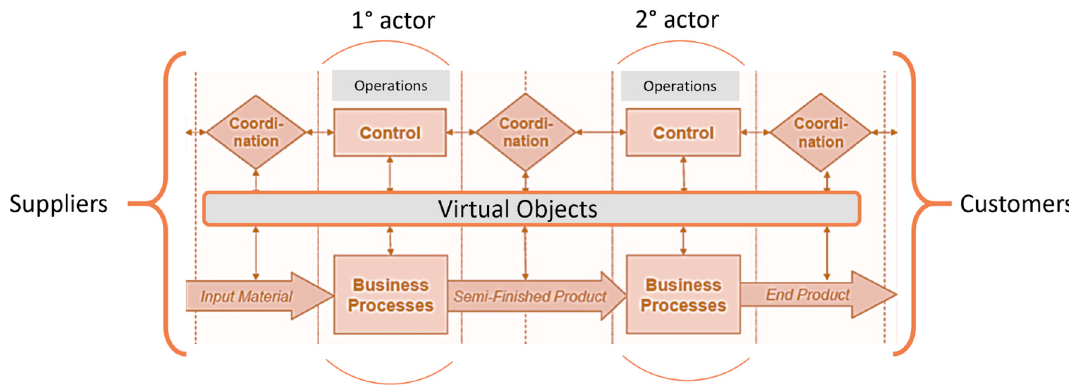
Figure 4. Virtualization of a supply chain management through the Internet of Things (IoT). Source: own elaboration.